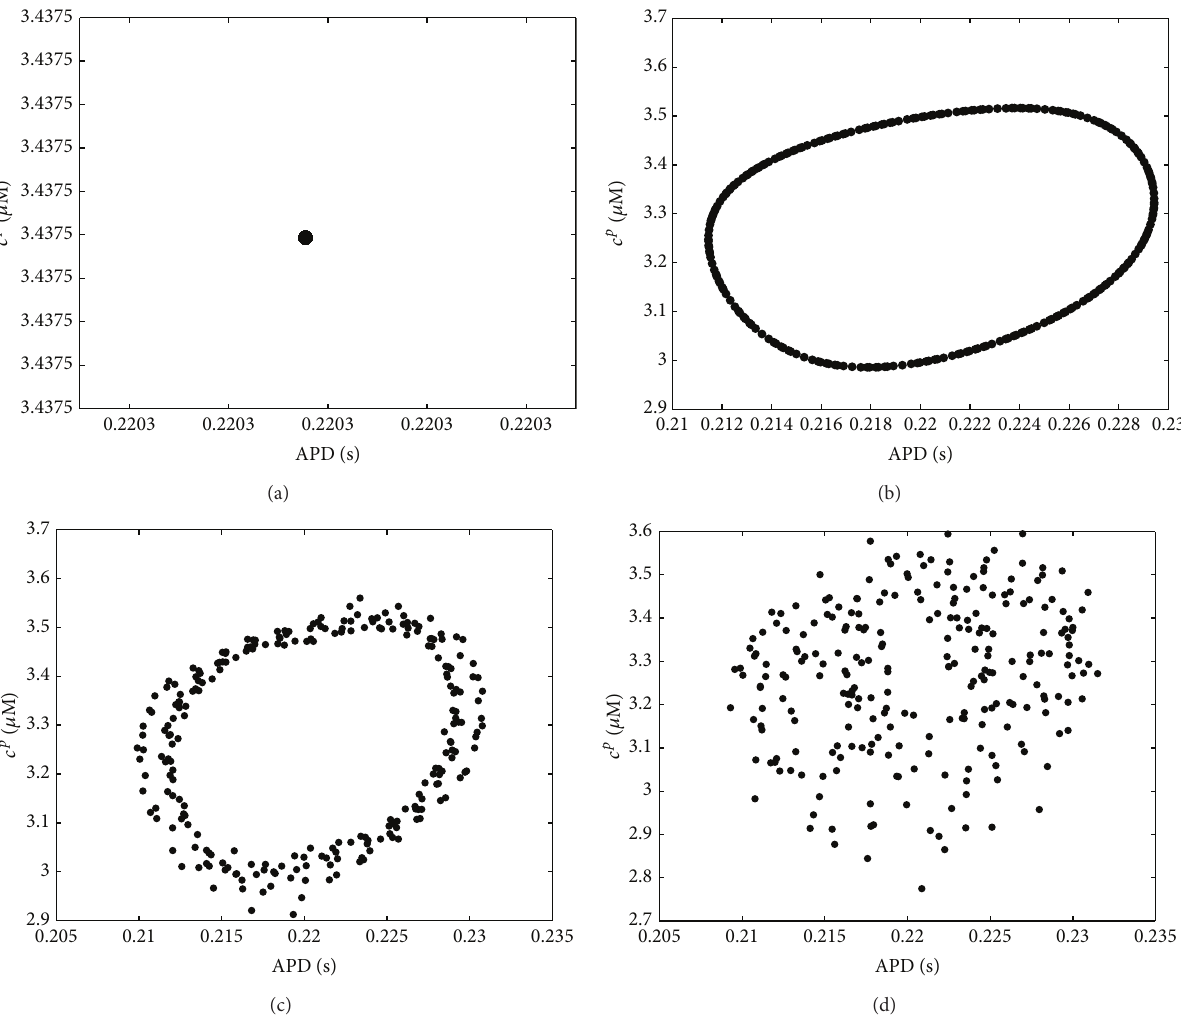
Figure 3: Hopf bifurcation for the coupled system (10), plots of peak calcium 𝑐 𝑝 versus APD, where 𝑇 = 0.27, 𝑤 = 0.478 , and the other parameters are the same as that in Figure 2. (a) 𝜖 = 0 , and 𝑐 𝑡 = 1.9 . (b) 𝜖 = 0 , and 𝑐 𝑡 = 1.85 . (c) 𝜖 = 0.02 , under the other conditions same as in (b). (d) 𝜖 = 0.1 , under the other conditions same as in